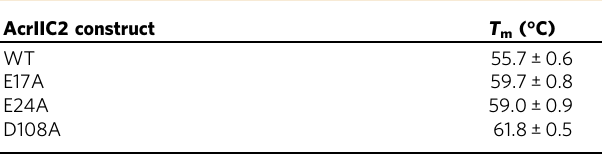
Table 3 Thermal stability values ( T m ) derived by